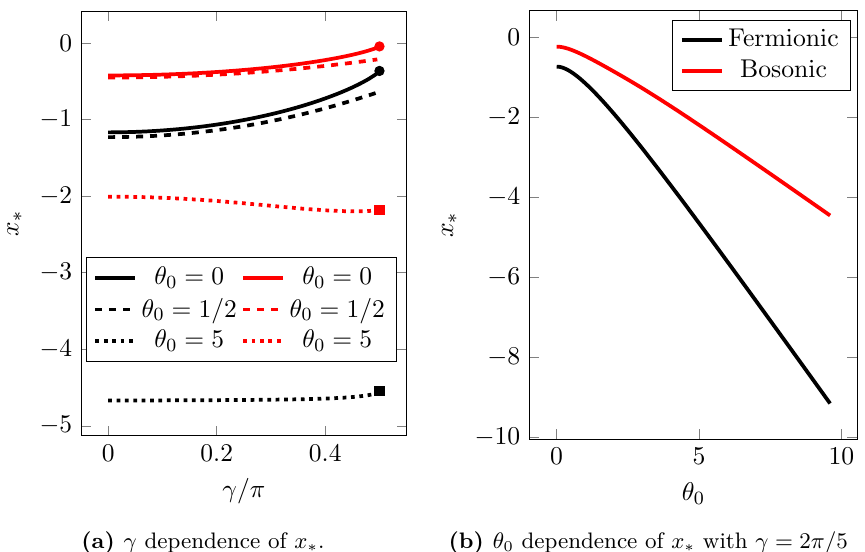
Figure 8. Dependence of the critical x ∗ in the model parameters. Black lines correspond to fermionic 2CDD models, red lines correspond to bosonic ones. On (a), we demonstrate the validity of the narrow resonance limit approximation for x (red and black bullets/boxes), see in ∗